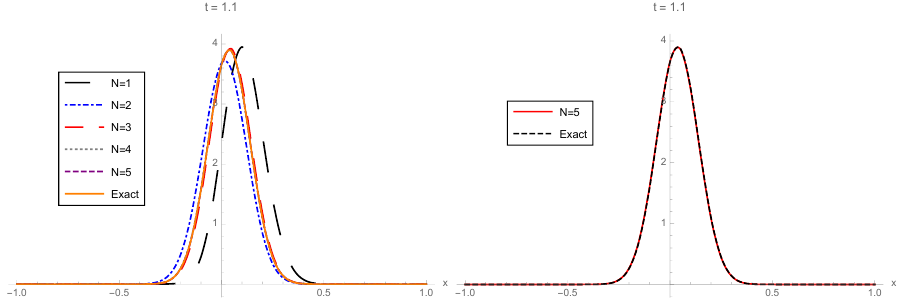
( x , t ) , of the truncated solution stochastic process (SP), X N ( t ) , to the random Figure 1. Left : 1-PDF, f N 1 initial value problem (IVP) (27) taking as the order of truncation N ∈ { 1,2,3,4,5 } and the corresponding 1-PDF, f 1 ( x , t ) , of the exact solution SP at t = 1.1. Right : To facilitate the comparison, f N with N = 5, is plotted together with f 1 ( x ,1.1 ) . Example